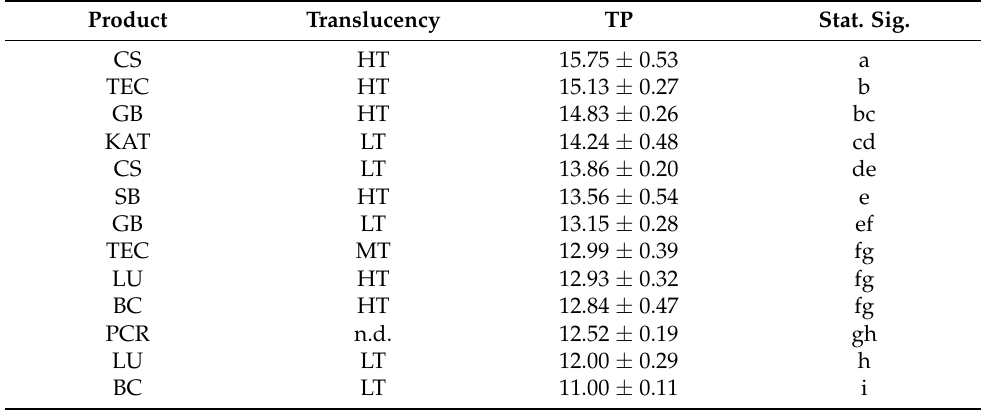
Figure 4. Graphic representation of CR for 1.0 mm of the investigated materials. TP (Table 3) varied from 15.75 (CS, HT) to 8.96 (KAT, OP), while TP 00 (Table 4) varied from 12.47 (CS, HT) and 6.31 (KAT, OP). Table 3. Translucency Parameter (TP) of the materials tested. Materials are listed from the highest TP (more translucent) to the lowest TP